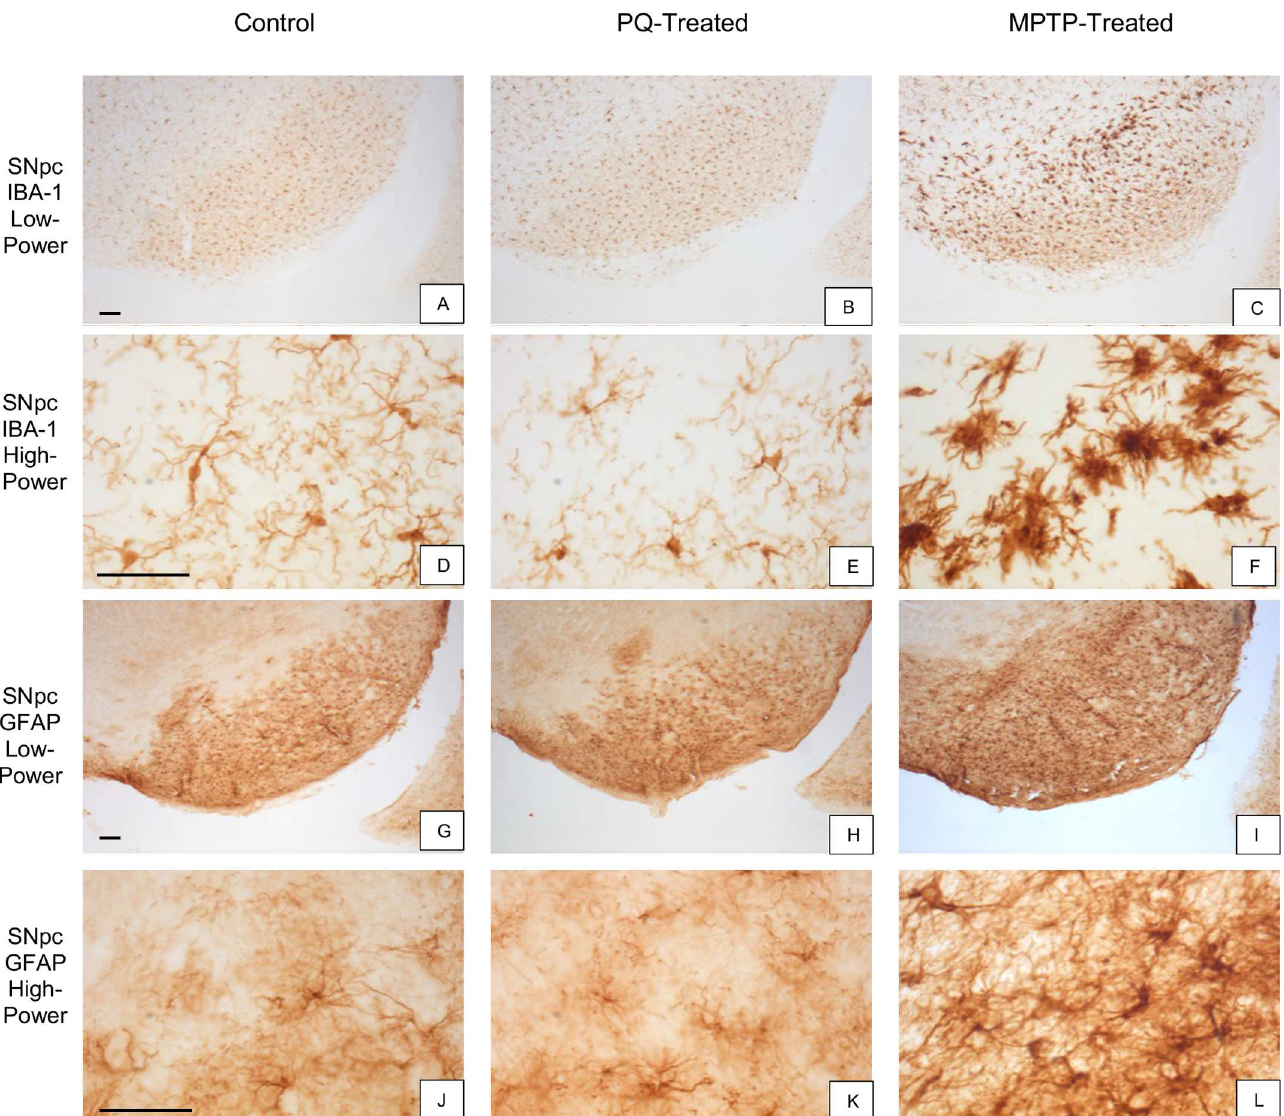
Fig 6. Appearanceof microglia and astrocytesin SNpc and striatum of PQ- and MPTP-treated mice. Microscopicappearanceof Iba- 1-stainedmicroglia (A-F) and GFAP-stained astroctyes (G-L) in the SNpc of mice 48 hours after PQ (column 2) or MPTP treatment (column 3) comparedto a control (column 1). Iba-1 immunostaining of microglia was increasedin the MPTP-treated mouse (C, F) but was not different in the PQ-treated mouse (B, E) compared to the control (A, D). Similarly, increasedGFAP immunostaining of astrocytes was noted in the MPTP-treated mouse (I, L) but not in the PQ-treated mouse (H, K) compared to the control (G, J). Scale bar A-L 40 μ